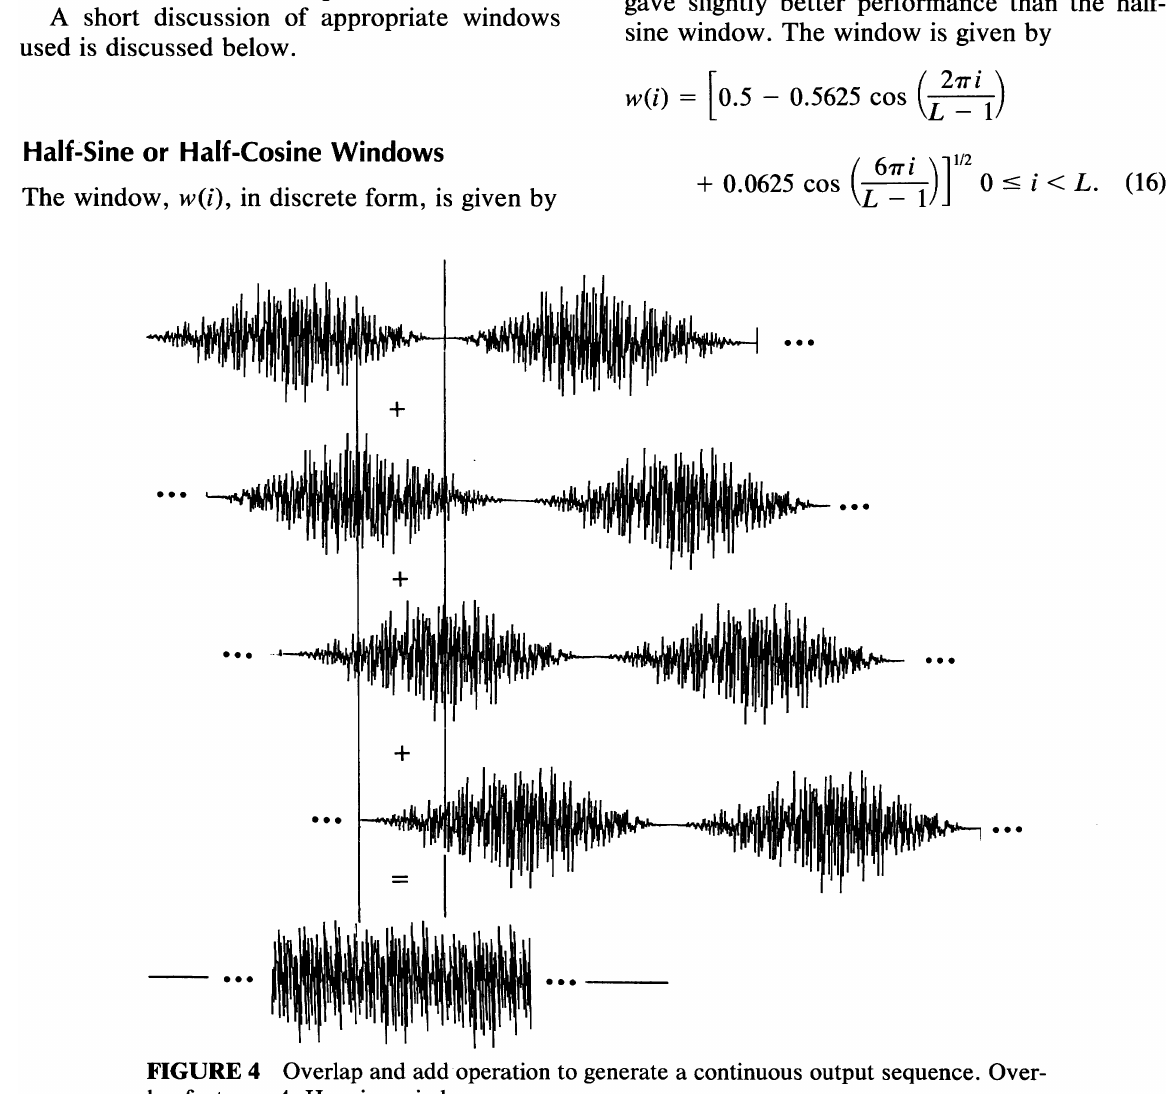
FIGURE 4 Overlap and add operation to generate a continuous output sequence. Over lap factor = 4, Hanning